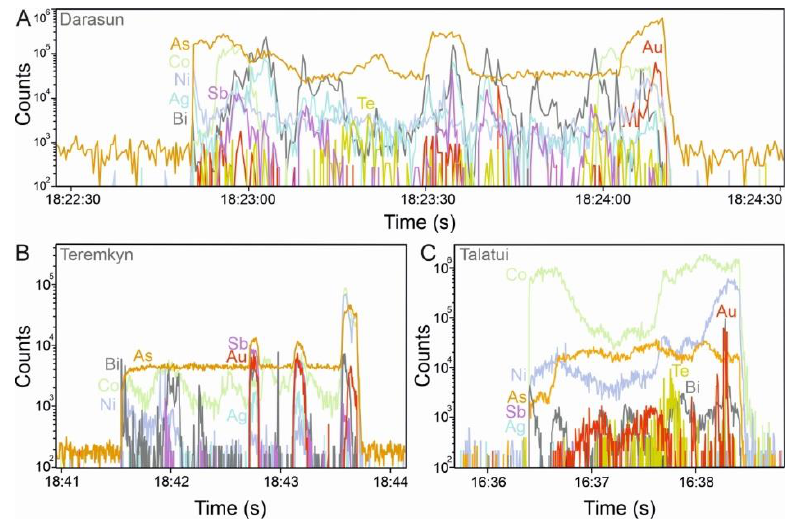
Figure 9. Time-resolved signal counts for trace elements for LA-ICP-MS profiles in pyrite from